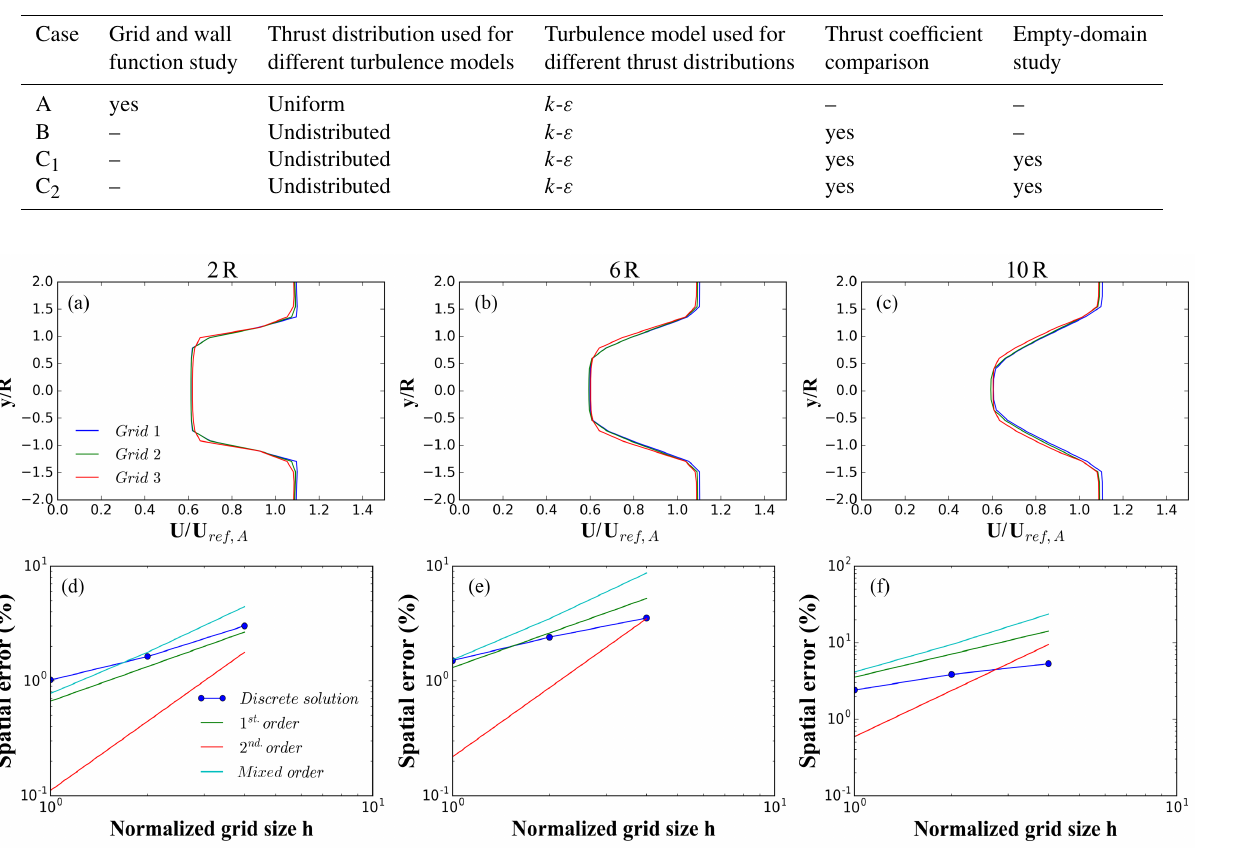
Figure 3. Normalized axial velocity and spatial discretization error computed behind a single model wind turbine (case A) for three grids at (a, d) x/R = 2, (b, e) x/R = 6 and (c, f) x/R = 10 for the k - ε turbulence model and the undistributed